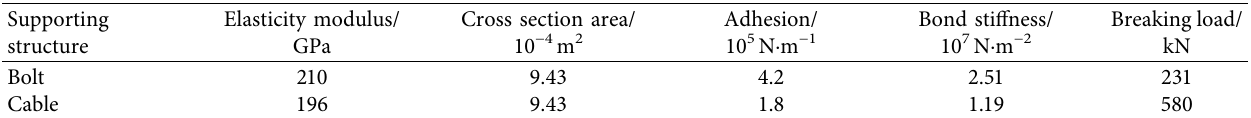
Figure 16: Monitoring results of mine pressure in area I. (a) Monitoring results of typical super large section surrounding rock convergence. (b) Cables working resistance monitoring results of typical super large section roof and two shoulder. Table 2: Numerical calculation parameters of